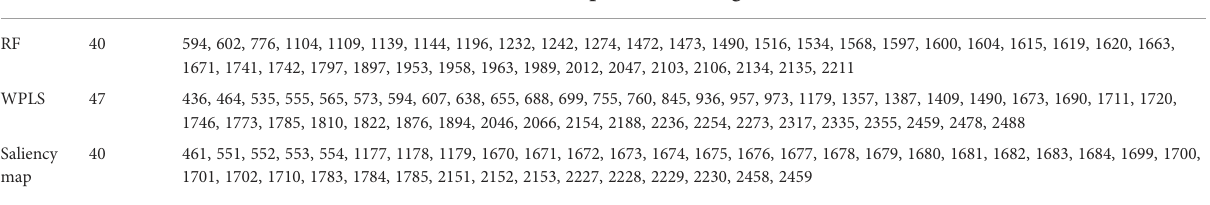
TABLE 2 The optimal wavelengths selected by RF, WPLS, and saliency map for regression models. Method